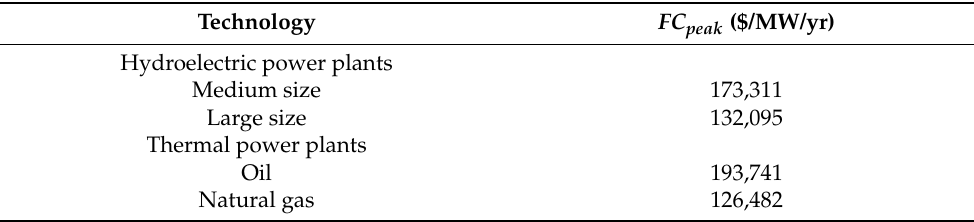
Table 5. Annualized fixed investment cost of a peaker